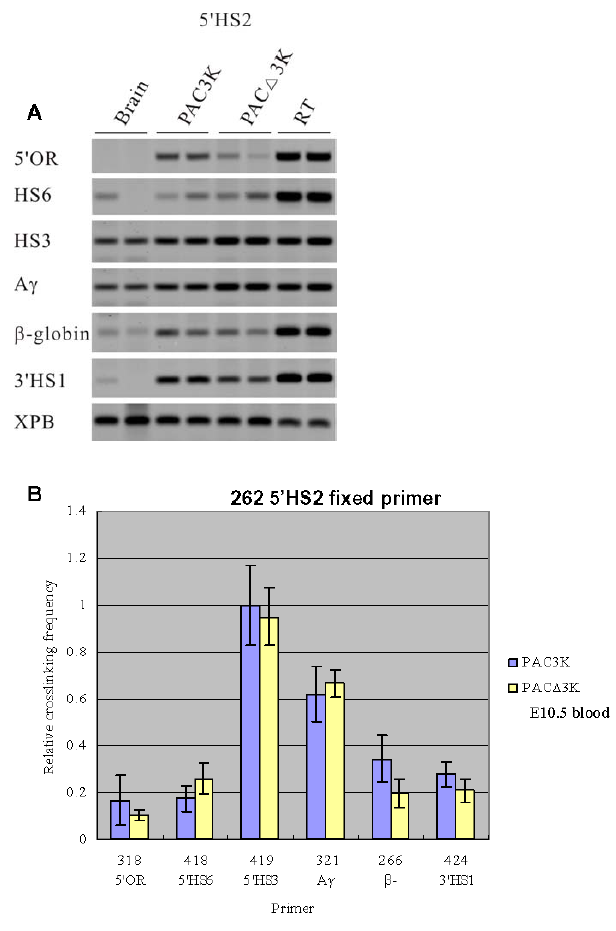
Figure 4. 3C analysis of the PAC3K and PAC D 3K transgenes using a primer from 5 9 HS2 as the fixed primer. Embryonic blood was collected from E10.5 embryos for this set of 3C experiments. (A) Representative examples of the PCR fragments resulting from the 3C experiments. RT: Random template control. (B) Histogram of the relative crosslinking efficiencies after quantitation and